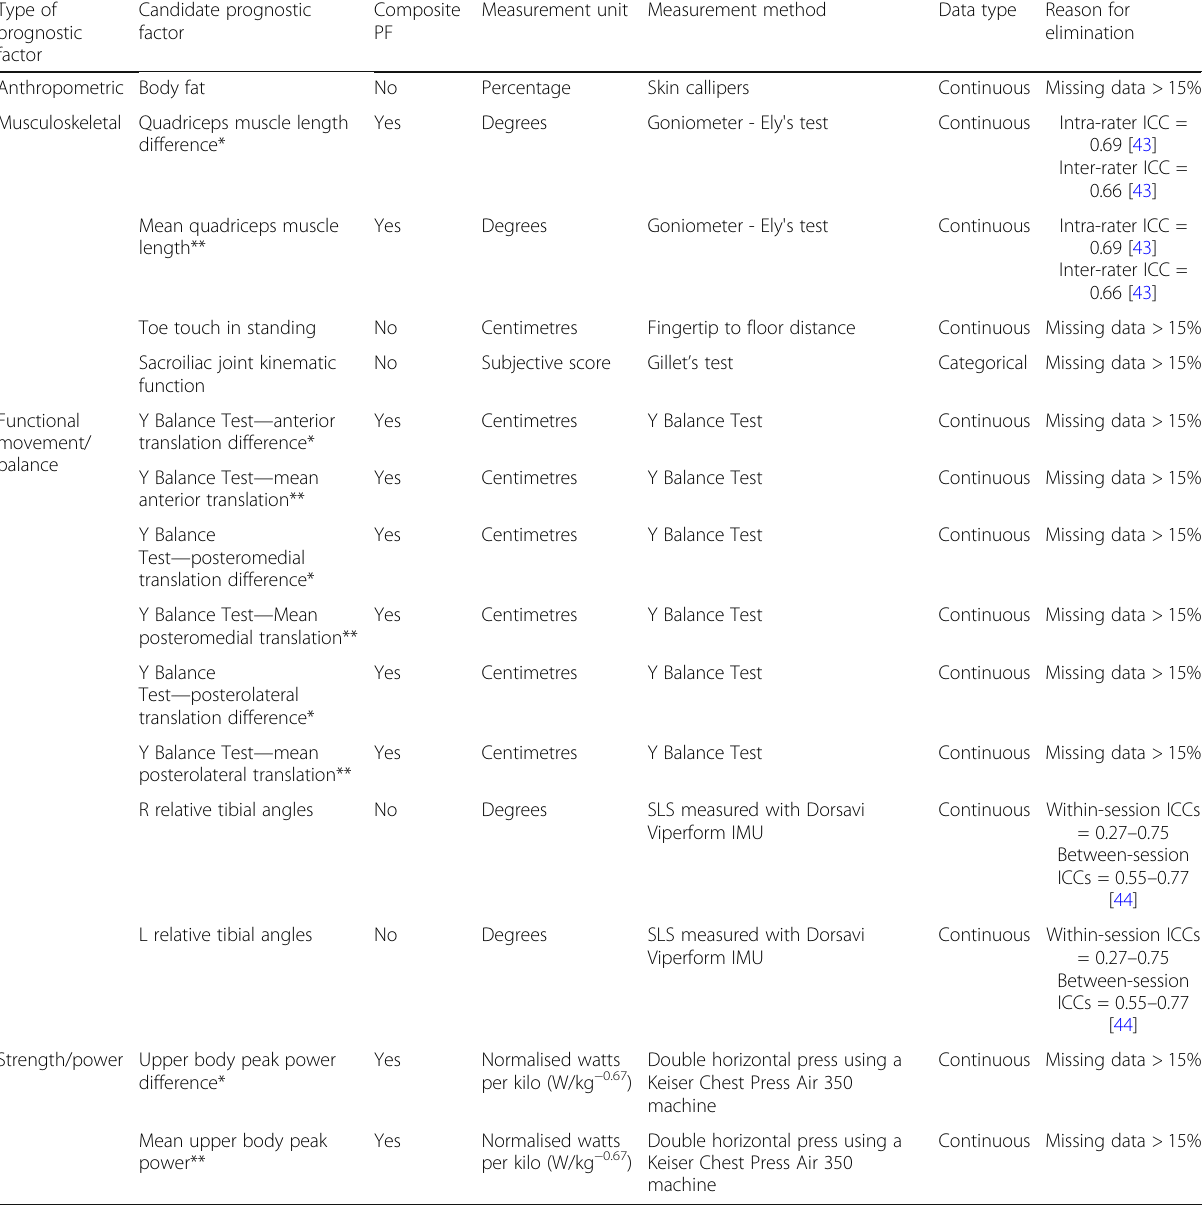
Table 4 Candidate prognostic factors excluded from both model development and prognostic factor exploration Type of